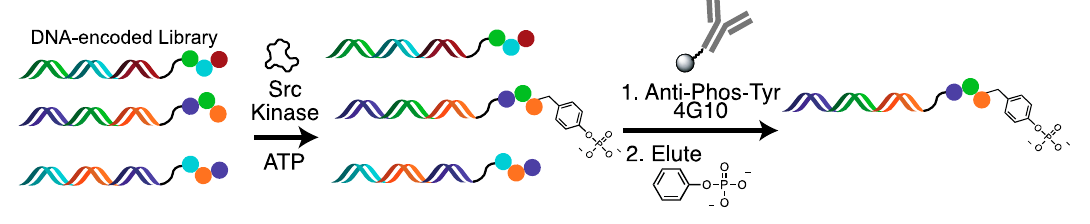
Figure 1 . Src kinase substrate selection scheme. Figure 1. Src kinase substrate selection